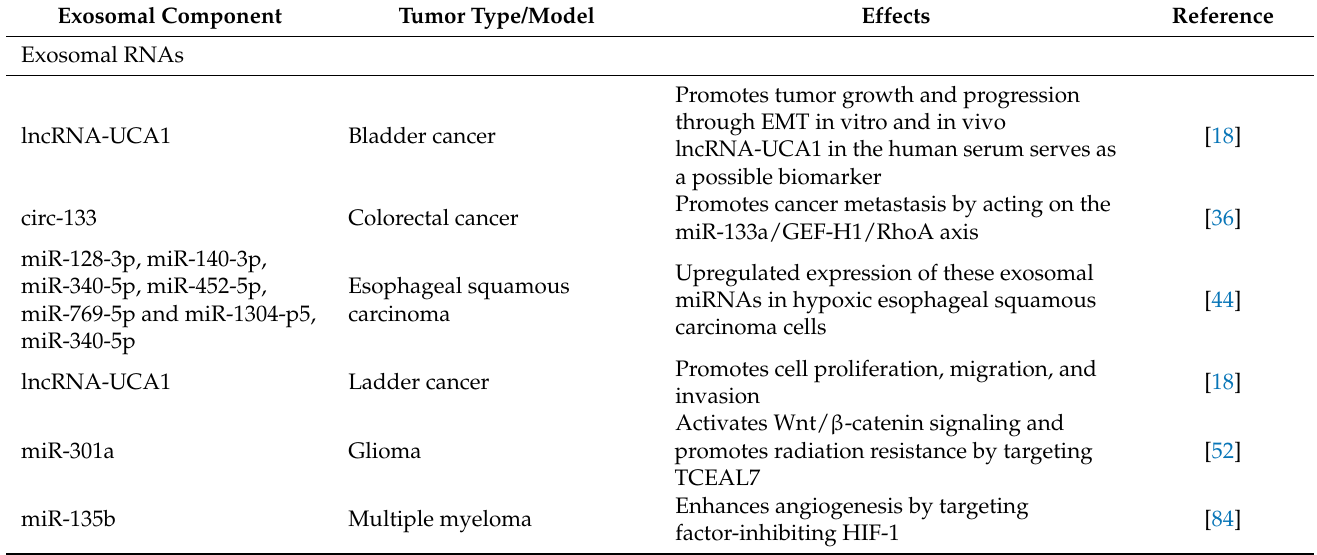
Table 1. Hypoxia-induced exosomal cargos and effects on